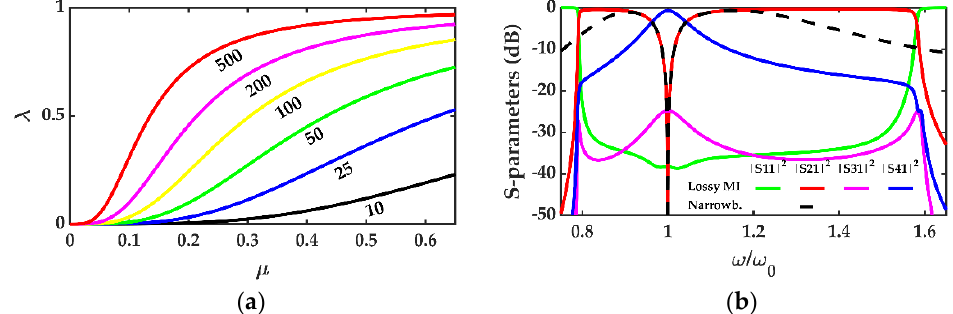
Figure 4. ( a ) Variation of λ with µ for different unloaded resonator Q-factors with κ = 0.6. ( b ) Frequency dependence of scattering parameters for infinite rejection filter with lossy MI and resistive narrowband terminations with κ = 0.6, κ c = 0.3, and Q = 200.